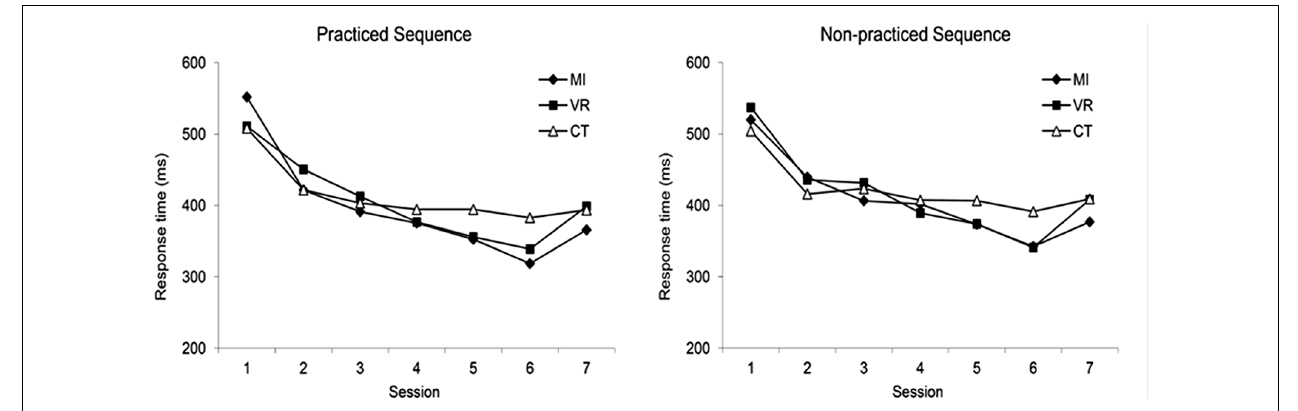
FIGURE 1 | Mean response times for the practiced and non-practiced sequence, in each group, across the seven sessions.